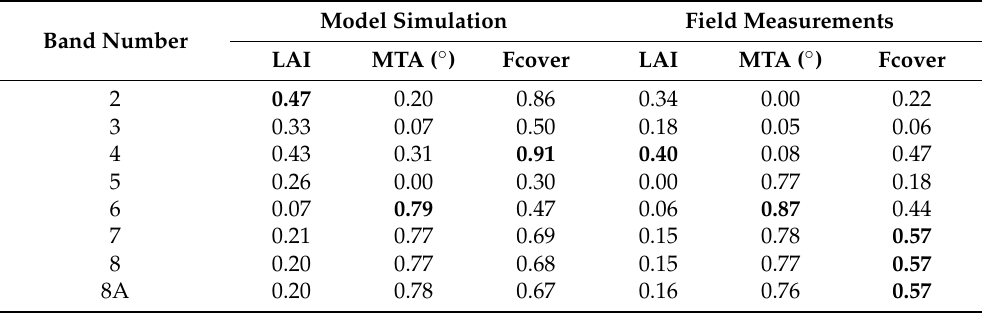
Table 4. The coefficients of determination, R 2 , between canopy structure parameters and simulated Sentinel-2 bands.